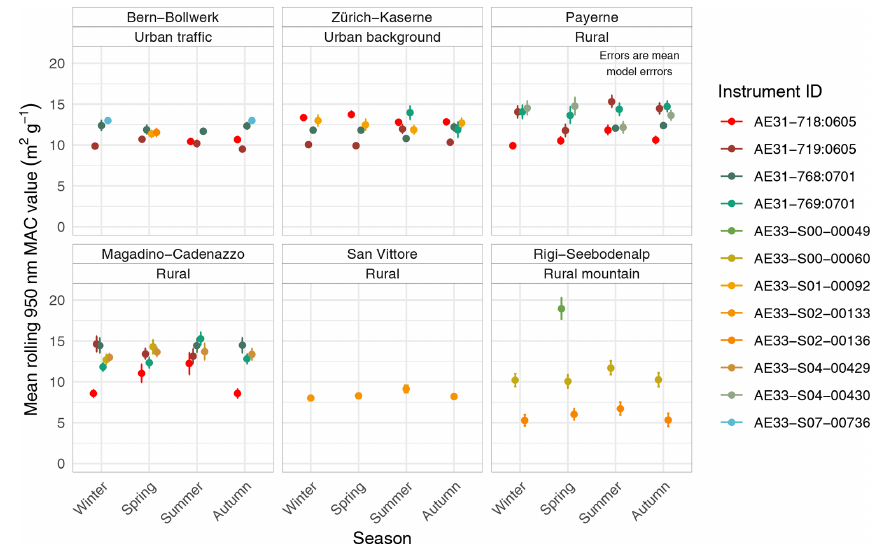
Figure A2. Mean seasonal and instrumental mass absorption cross-section (MAC) coefficients for 950nm for six equivalent black carbon (EBC) monitoring sites in Switzerland between 2008 and 2018.